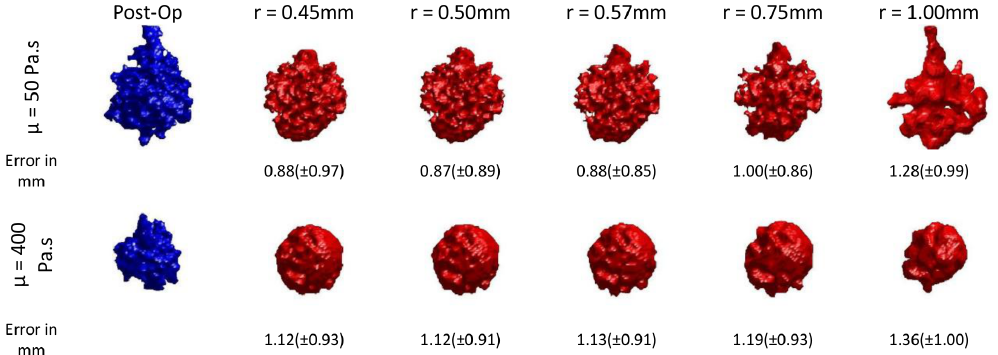
Figure 6. Effect of particle size on the accuracy of the cement cloud.